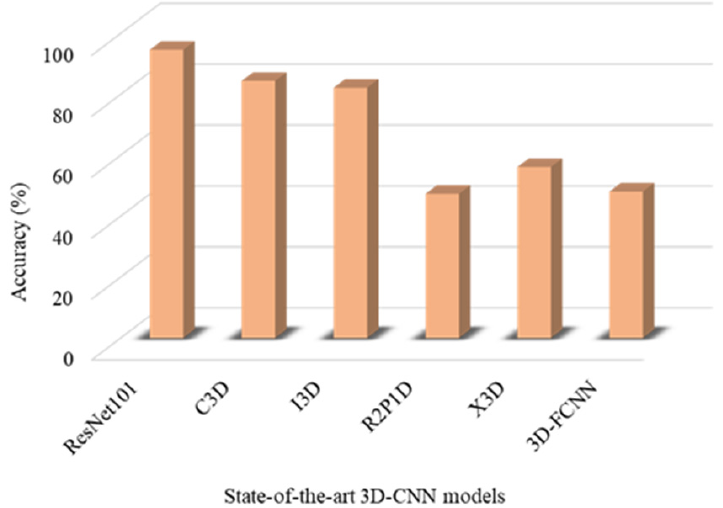
Figure 5. Comparison of recognition results for different 3D-CNN models on the UTD-MHAD data using SSIM metric having k = 24.